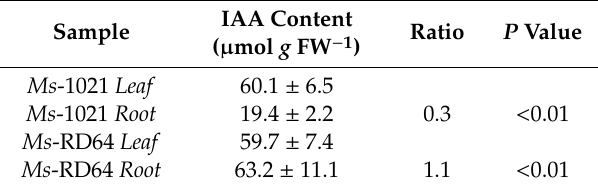
Table 1. Indole-3-acetic acid (IAA) levels in Medicago sativa plants nodulated by the strains 1021 and